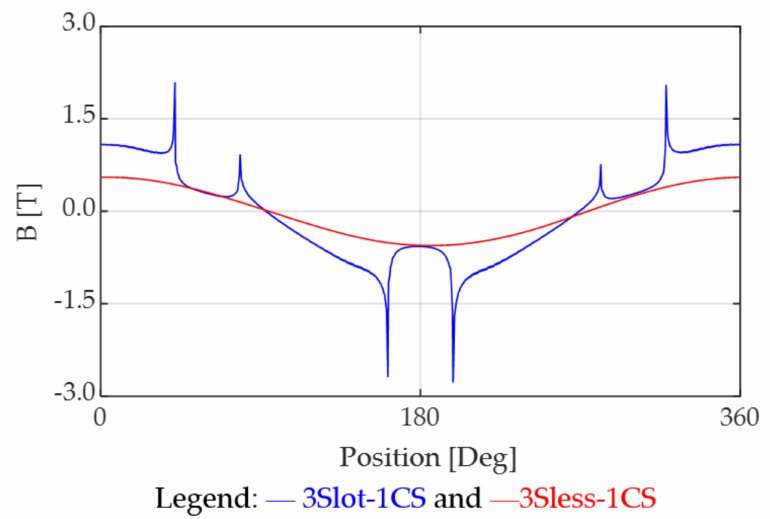
Figure 6. Comparison of magnet flux density distribution along the air gap: 3Slot-1CS and 6Sless-2CS (no